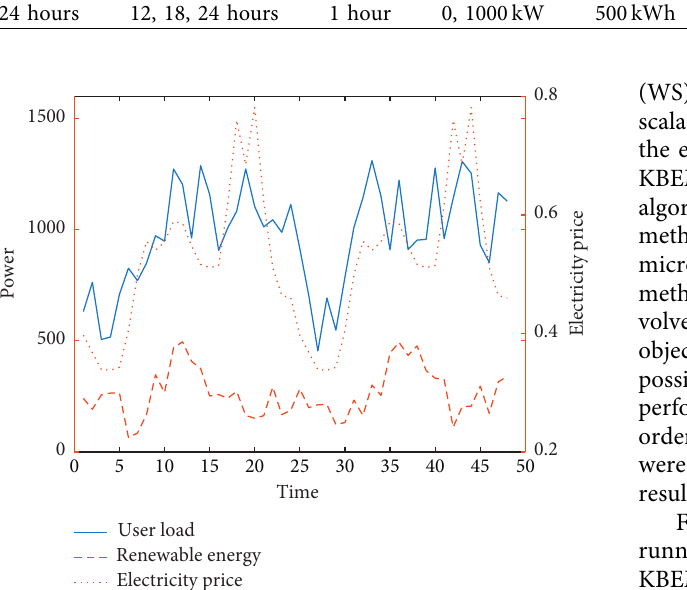
Figure 4: Schematic diagram of microgrid user load, renewable energy generation, and time-of-use electricity